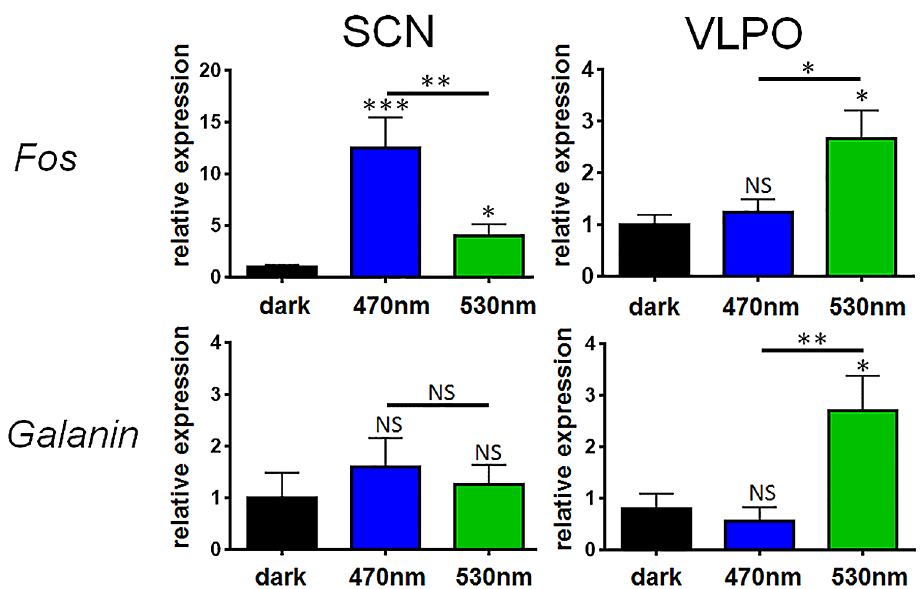
Fig 6. Molecular responses to light in SCN and VLPO are wavelength-dependent. A Fos induction in response to a 30 min light pulse was studied in wildtype mice exposed to blue or green light in both the SCN and VLPO (two-way ANOVA for wavelength x brain region interaction F (2,31) = 10.968 p (cid:1) 0.001). Mice exposed to blue light show greater Fos induction in the SCN compared with green light (posthoc Tukey dark versus blue p = 0.001, dark versus green p = 0.035, blue versus green p = 0.008). By contrast, in the VLPO, a greater response to green light than blue light was observed (dark versus blue p = 0.880, dark versus green p = 0.015). As a control, Gal induction was also studied, showing no induction in the SCN but significant induction in the VLPO (two-way ANOVA for wavelength and x brain region interaction F (2,30) = 3.774 p = 0.035). This response was only evident in response to green light (posthoc Tukey dark versus blue p = 0.742, dark versus green p = 0.011, blue versus green p = 0.003). Histograms show mean ± SEM, n = 5 – 8/group. Significant differences indicated by *** p (cid:1) 0.001, ** p (cid:1) 0.01, * p (cid:1) 0.05, NS = not significant. The data used to make this figure can be found in S6